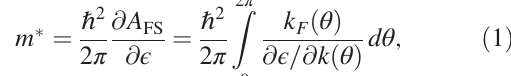
FIG. 2. (a) Quasiparticle dispersions measured with p -polarized light, for different azimuthal angles θ as defined in panel (b). (c) Angular dependence of the quasiparticle velocity v along the β and γ Fermi surface sheets. (d) Angular dependence of the F =v quasiparticle mass enhancement v . Here, v is the bare velocity obtained from the single-particle Hamiltonian b F b ˆ H SOC λ Δ λ defined in Sec. IV, and v F is the quasiparticle Fermi velocity measured by ARPES. Error bars are obtained by propagating the DFT þ experimental uncertainty on v F